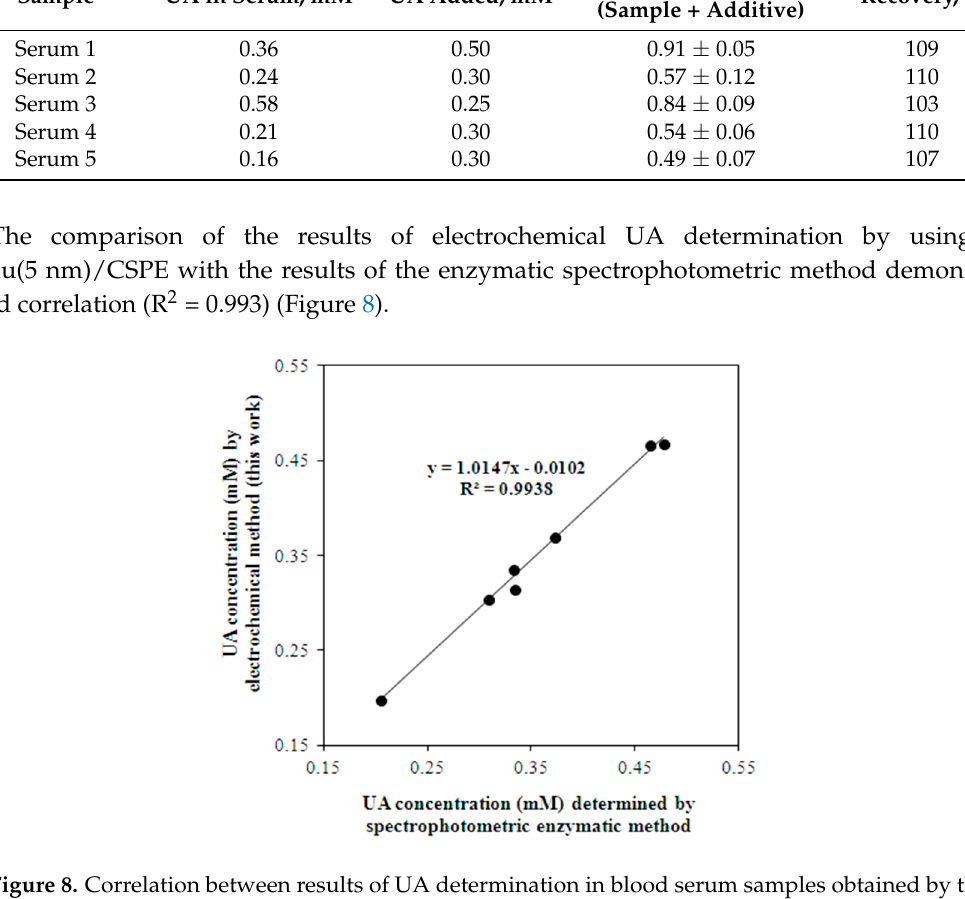
Table 4. Analysis results of blood serum samples using 2.5% Nf/Au(5 nm)/CSPE ( n = 3, P = 0.95). Sample